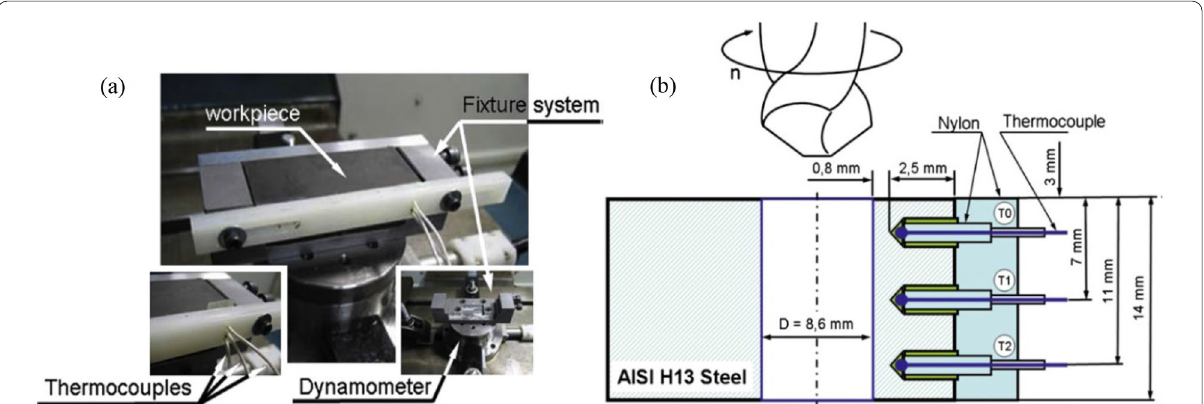
Figure 7 Thermocouple embedded into the workpiece a The experimental set-up, b Layout of the embedded thermocouples [40]